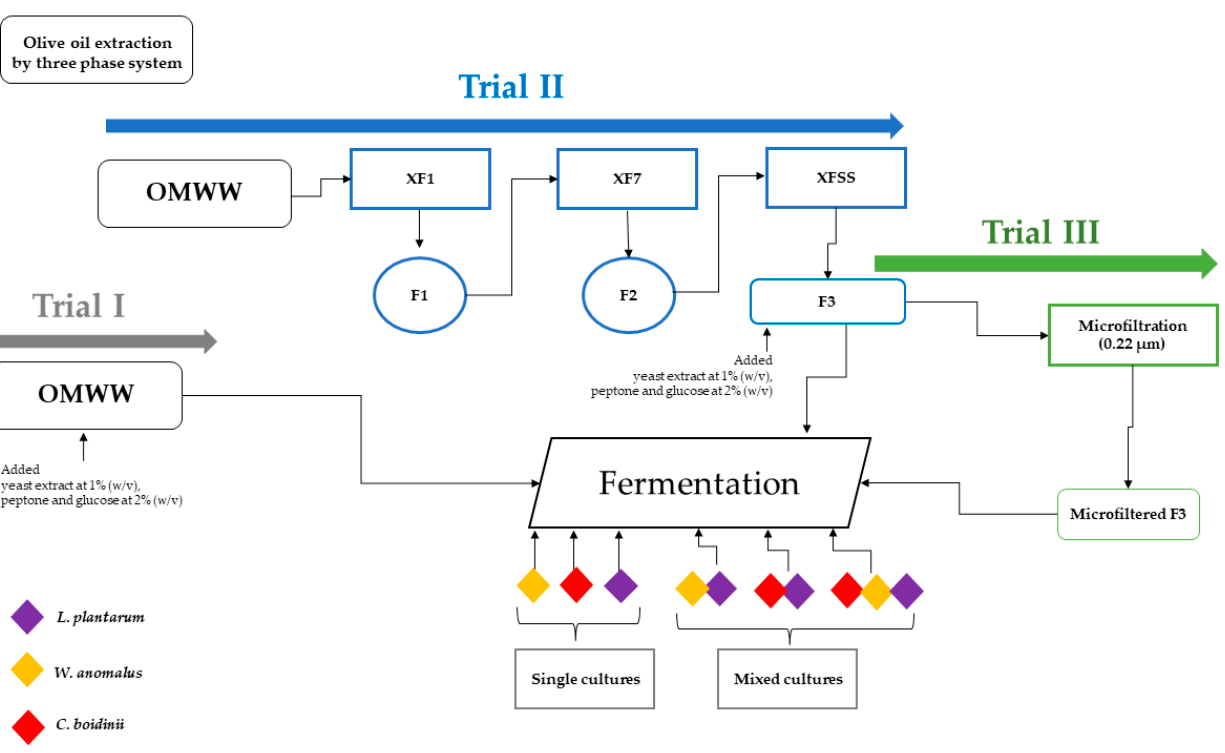
Figure 4. Fermentation process and OMWW obtained Trials.